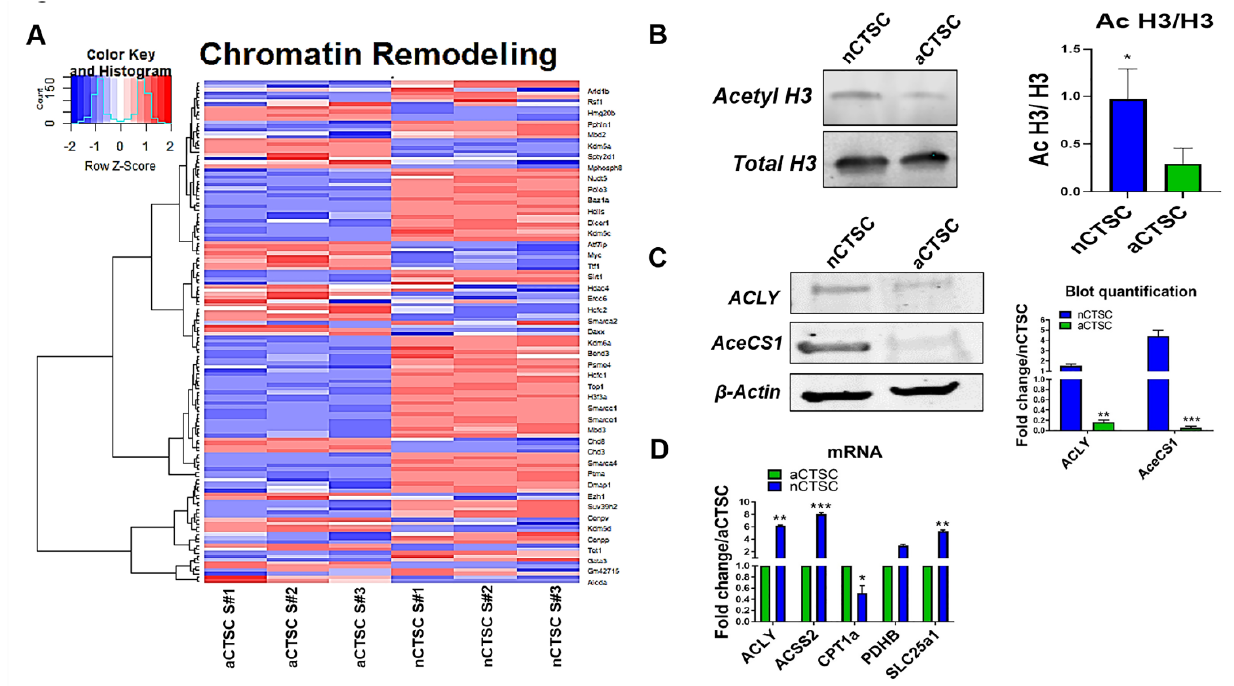
Figure 5. Acetyl-CoA-mediated modulation of chromatin modifications and histone acetylation in nCTSC. ( A ) Assessment of genes involved in GO term: chromatin remodeling. ( B ) Increased expression of Acetyl H3: total H3 found in nCTSC compared to aCTSC (n = 3). ( C ) Immunoblot revealing increased protein expression of ACLY and AceCS1 in the nCTSC (n = 3). ( D ) Increased mRNA expression of ACSS2 and glycolytic enzymes along with reduced fatty-acid metabolic activity present in nCTSC by qRT-PCR (n = 3). nCTSC vs. aCTSC * p < 0 .05, ** p < 0 .01, *** p < 0.001.